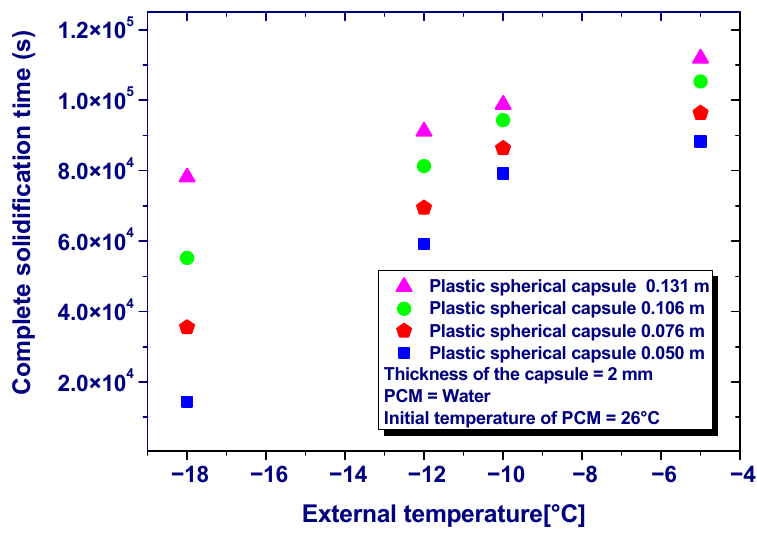
Figure 16. Impact of the dimension of the plastic spherical capsule on the complete solidification time. complete time for the whole mass of PCM to melt. The complete time for the melting process decreased with spherical capsule size due to the fact that the decrease enhanced heat dissipation to the solid phase change material and hence decreased the melting time. The increase in the thermal bath temperature reduced the complete time for the PCM mass to melt due to the high temperature gradient.